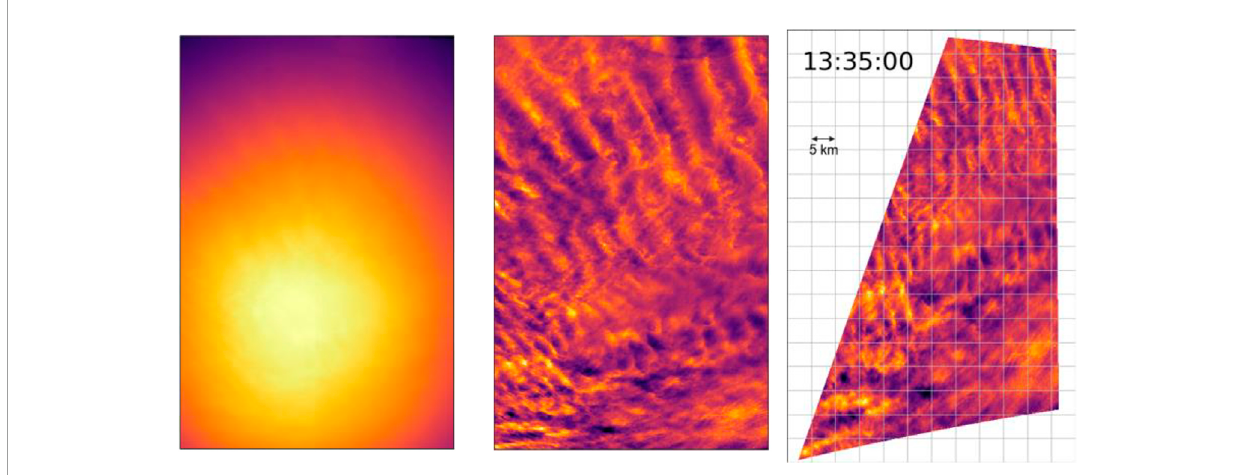
FIGURE 3 From left to right: raw false-colored image of one of the wide-field cameras containing PMCs; the same image after flat-fielding; and the same image after flat-fielding and projection based on the pointing solution. Up orientation in the first two images corresponds to the zenith, and up orientation in the projected image corresponds to the longitude of the sun. We projected the image looking from below. Figure originally published in Kjellstrand et al.